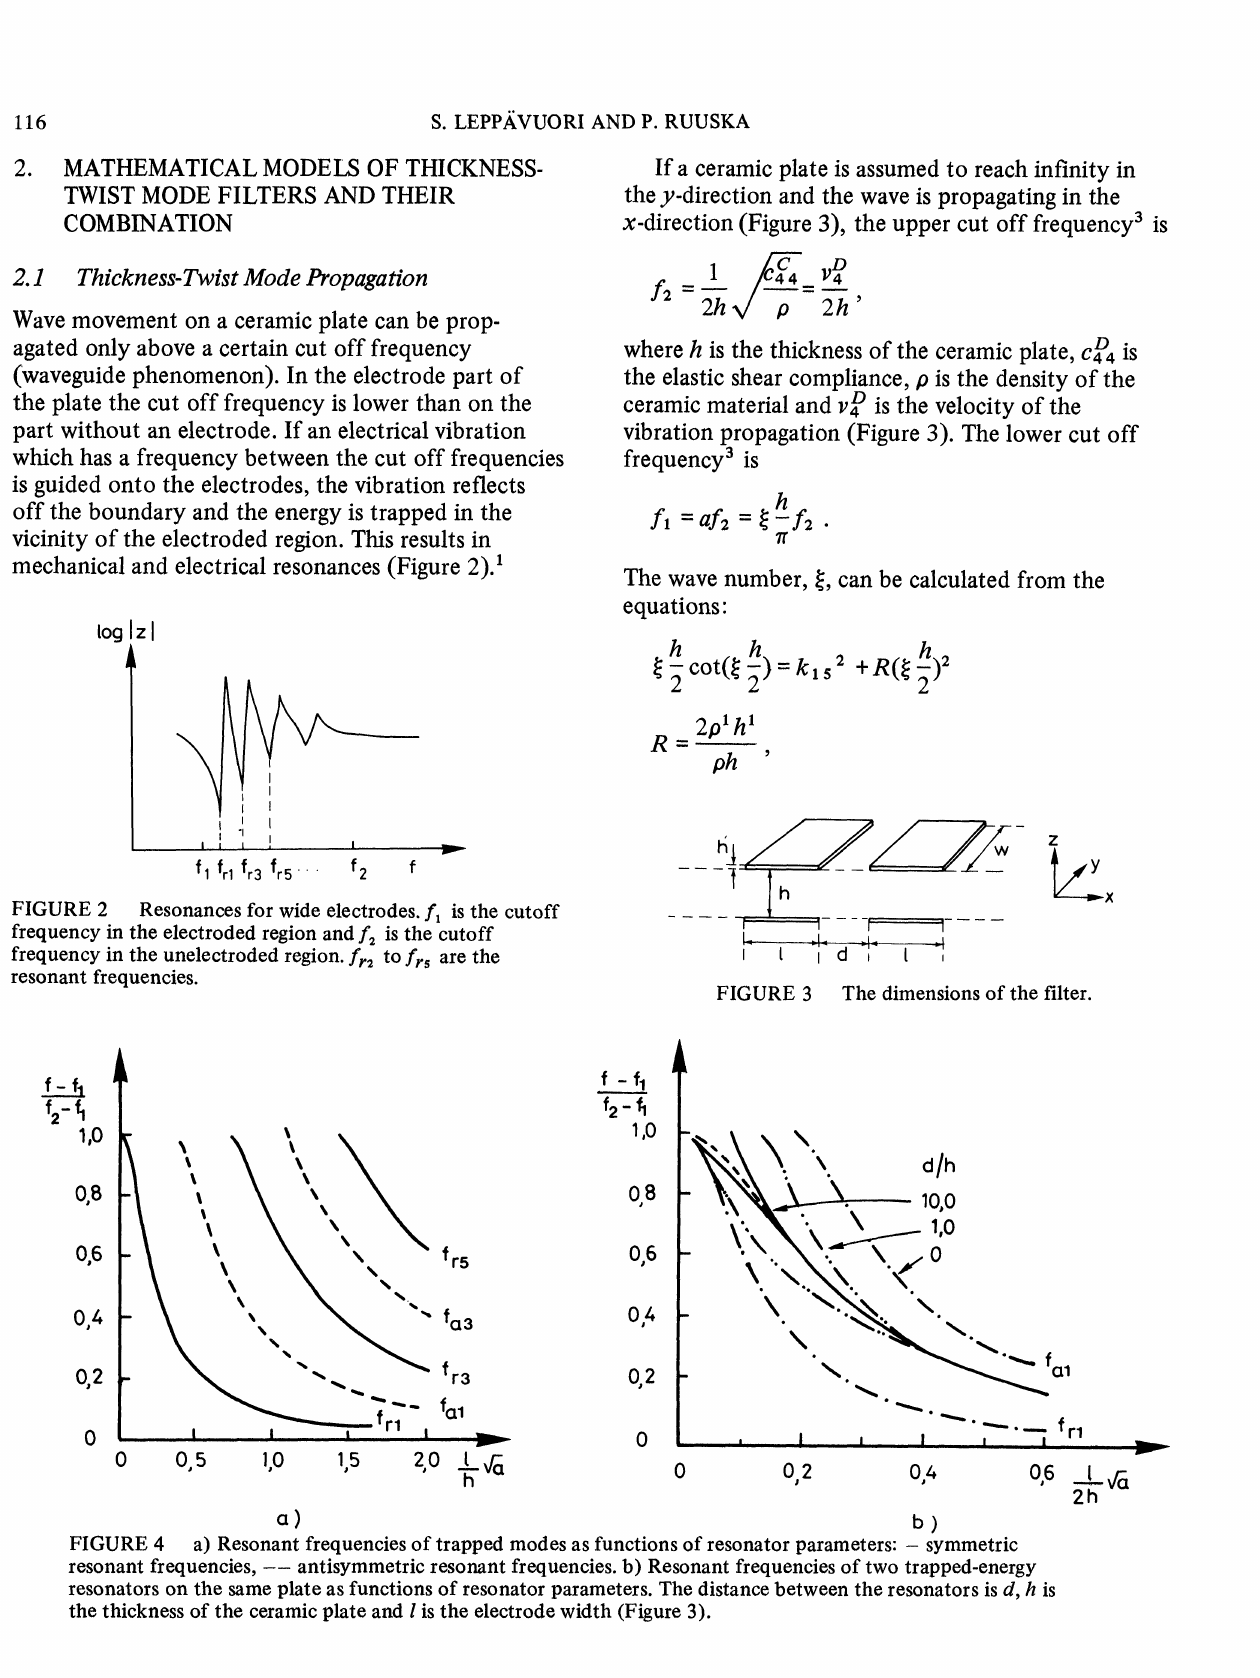
a) Resonant frequencies of trapped modes as functions of resonator parameters: symmetric resonant frequencies, antisymmetric resonant frequencies, b) Resonant frequencies of two trapped-energy resonators on the same plate as functions of resonator parameters. The distance between the resonators is d, h is the thickness of the ceramic plate and is the electrode width (Figure